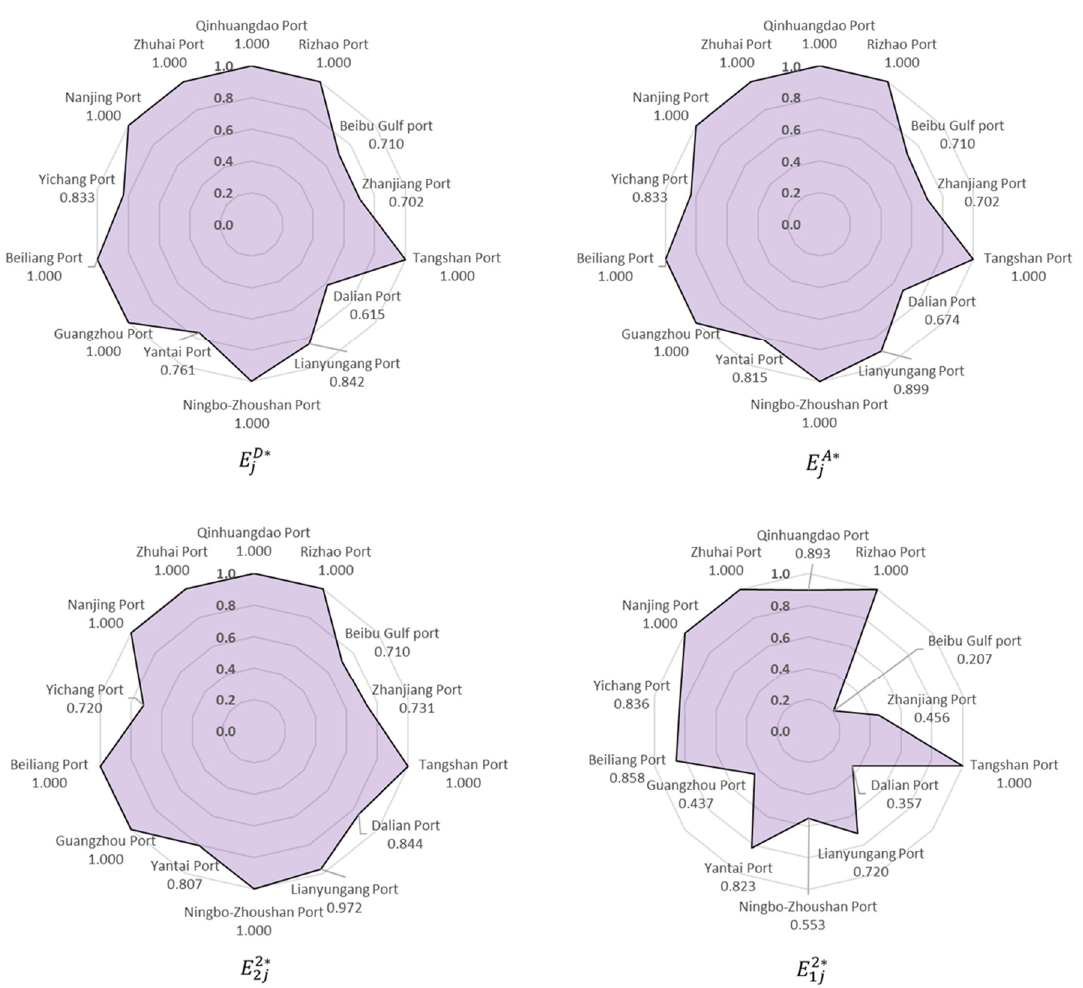
Figure 5. Calculation results of system efficiency and stage efficiency.